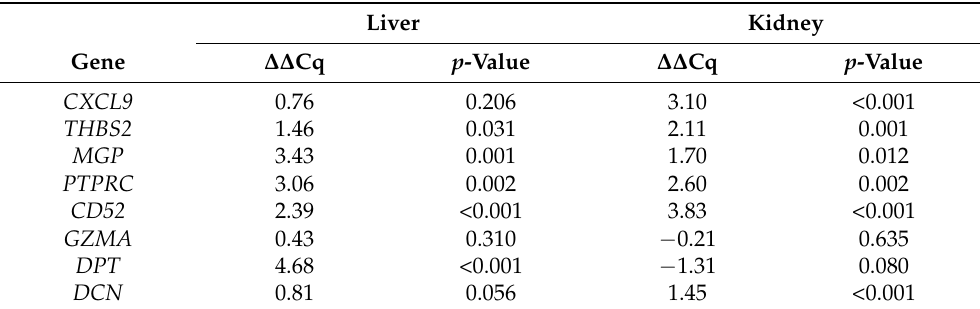
Table 3. Gene expression of CXCL9, THBS2, MGP, PTPRC, CD52, GZMA, DPT and DCN in fibrotic kidney and liver expressed as ∆∆ Cq relative to normal kidney and liver, respectively.